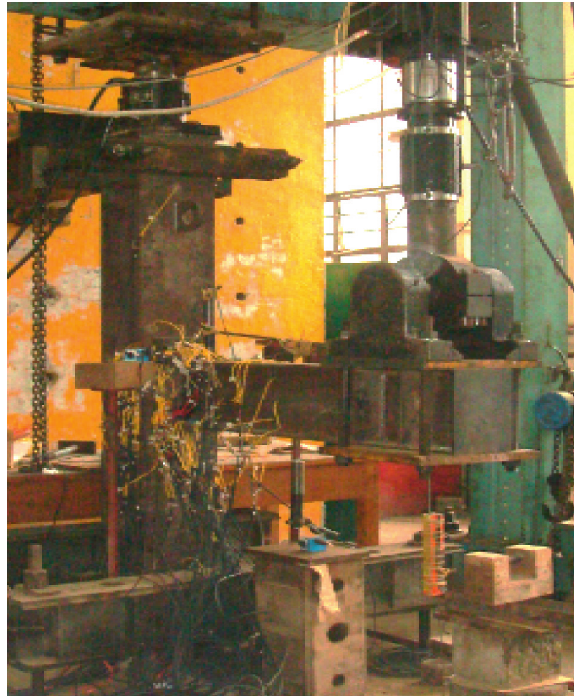
Figure 8: Test setup of T-stub connection for static